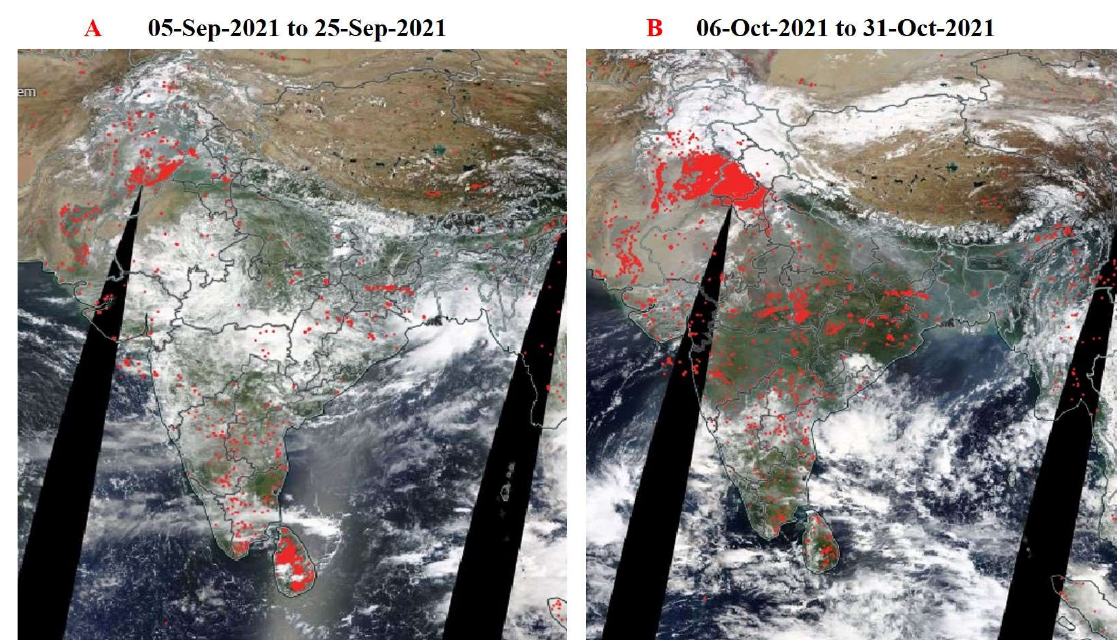
Figure 8. MODIS fire activity during the ( A ) pre-harvest and ( B ) post-harvest period.